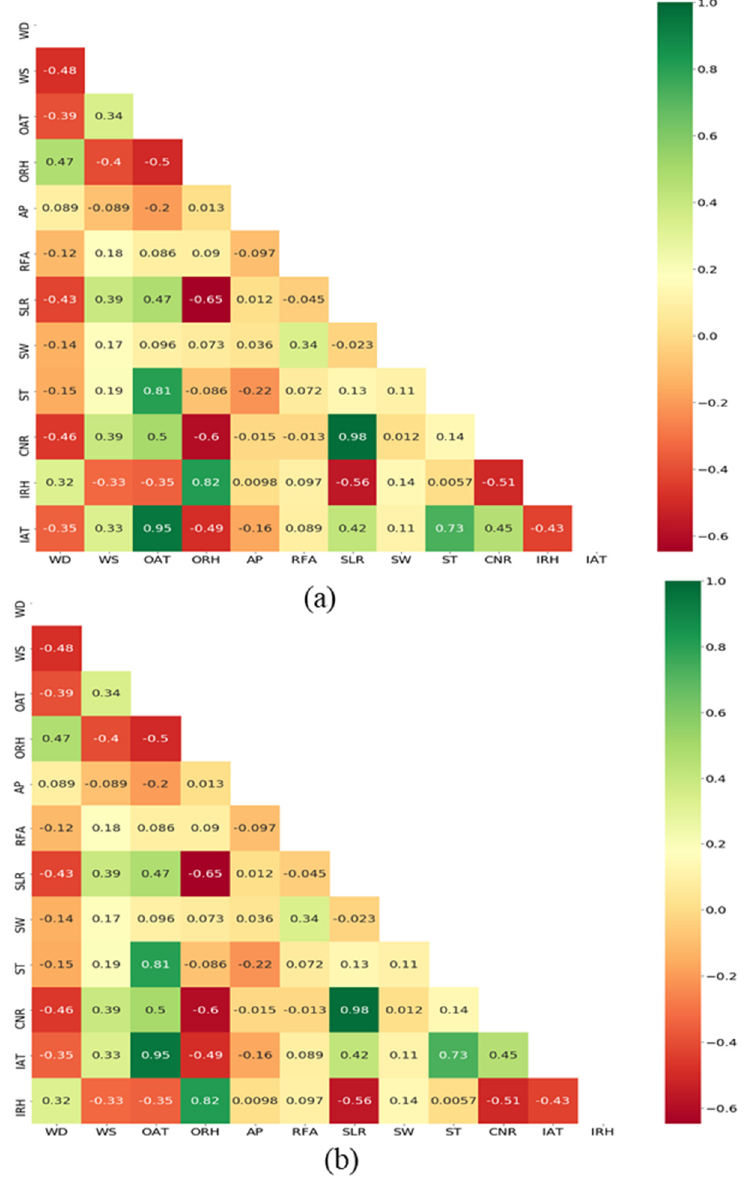
Figure 4. Heat correlation results between ( a ) Indoor air temperature (IAT) and ( b ) Indoor relative humidity (IRH) with other independent variables by using Spearman rank correlation coefficient approach. Table 2. Summary of the attributes which were chosen to train the model named S1, S2, and S3 during IAT and IRH predictions.